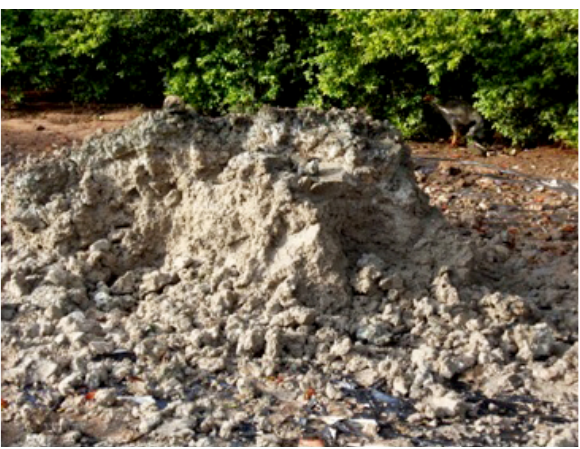
Figure 1. Appearance of the despectinated wet citrus pulp.